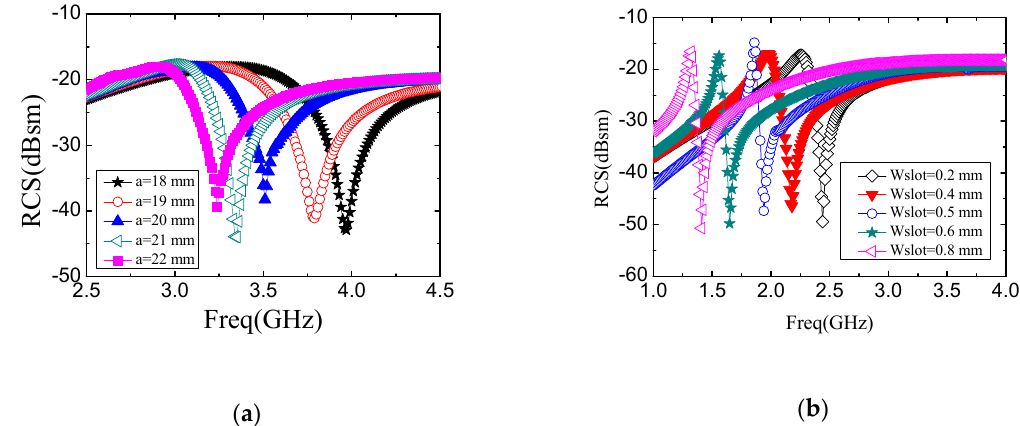
Figure 3. ( a ) Relationship of side length and resonant frequency with W slot = 0.5 mm. ( b ) Relationship between W slot and resonant frequency with a = 30 mm.